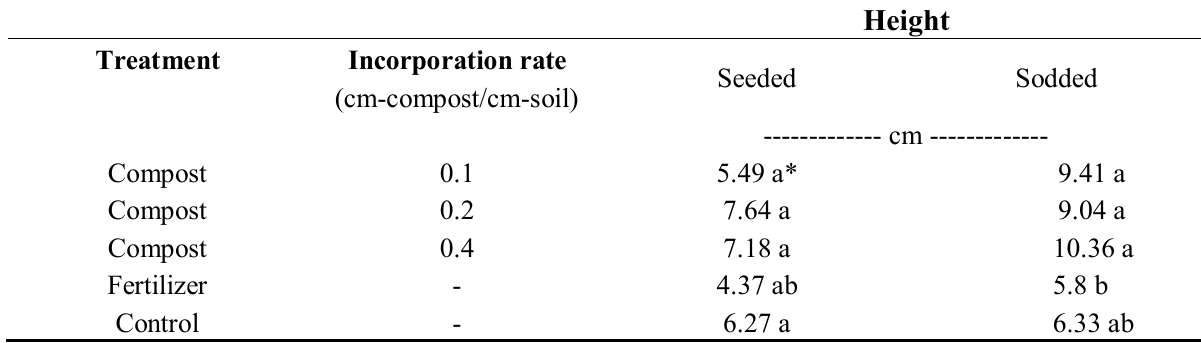
Table 1. Effect of compost treatments on seeded and sodded turf